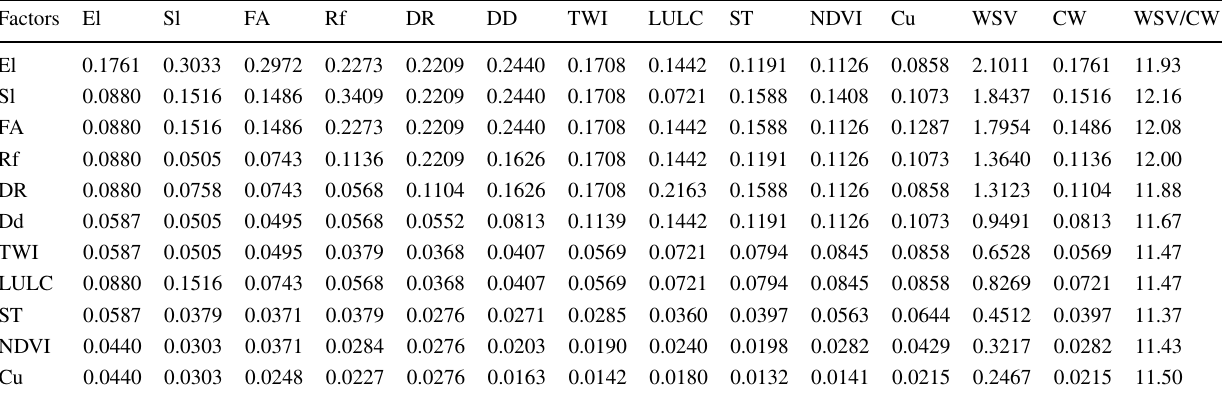
Table 5 Calculating the consistency of pairwise comparison (CR = 0.05)